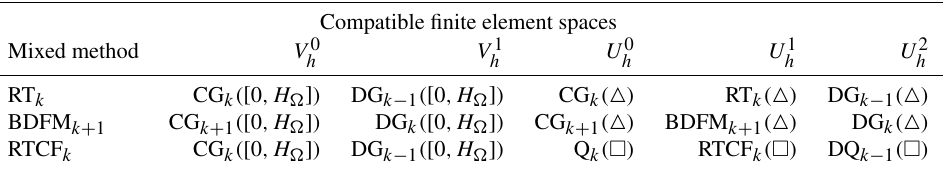
Figure 6. Snapshots (view from the northern pole) from the isolated mountain test case. The surface height (m) at days 5, 10, and 15. The snapshots were generated on a mesh with 20480 simplicial cells, a BDM 2 × DG 1 discretization, and (cid:49)t = 500s. The linear system during each Picard cycle was solved using the hybridization preconditioner. Table 5. Vertical and horizontal spaces for the three-dimensional compatible finite element discretization of the linear Boussinesq model. The RT k and BDFM k + 1 methods are constructed on triangular prism elements, while the RTCF k method is defined on extruded quadrilateral